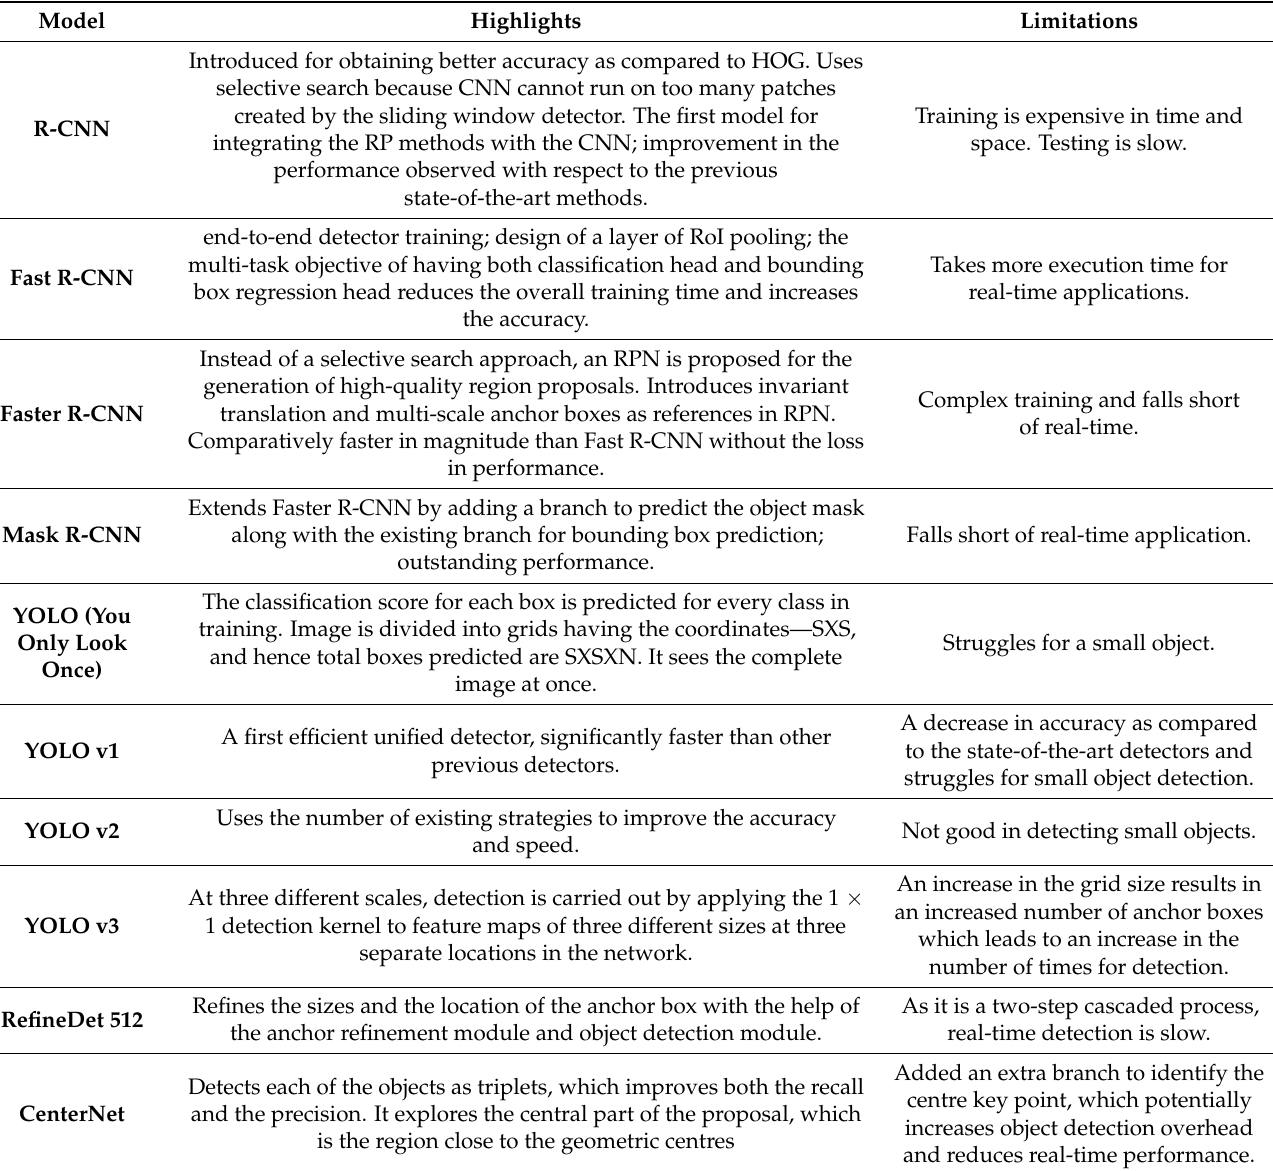
Table 1. Comparison of methods of object